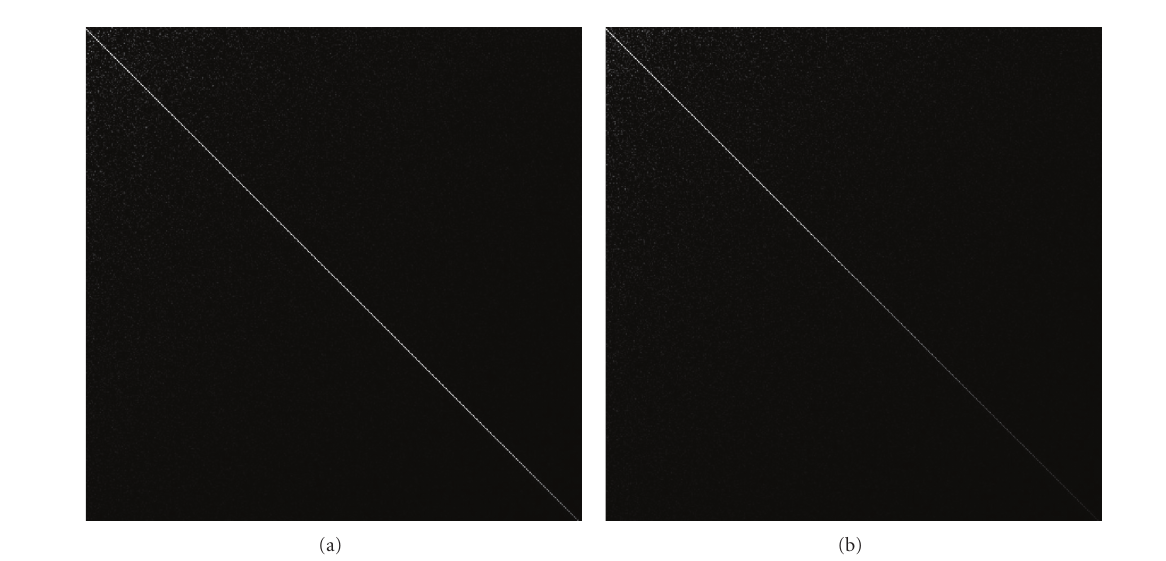
Figure 3: The new proposed technique: discriminant phase component.